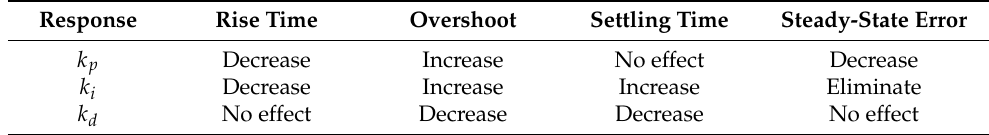
Table 1. Effects of proportional, integral and derivative gains of the PID controller.